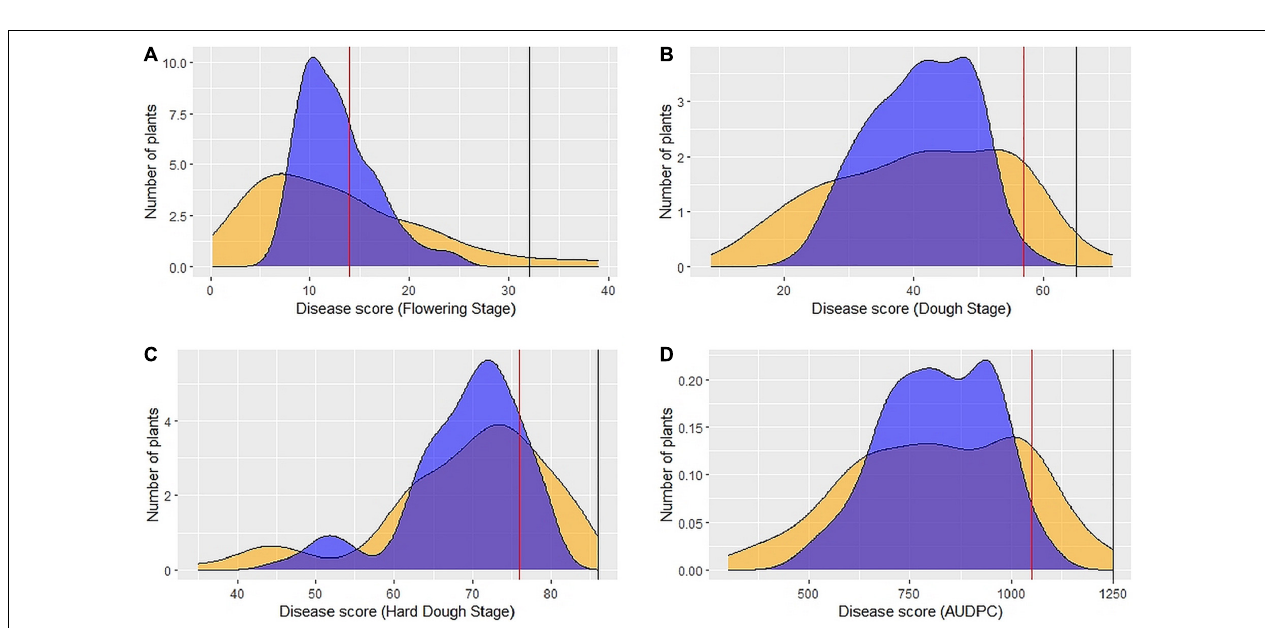
FIGURE 1 | Principal component analysis (PCA) biplot of disease severity of spot blotch across four individual environments E1, E2, E3, and E4 (turquoise color), across environment BLUEs (blue color), and across environment BLUPs (red color) for disease severity at flowering stage (FS), dough stage (DS), hard dough stage (HDS), and AUDPCs.